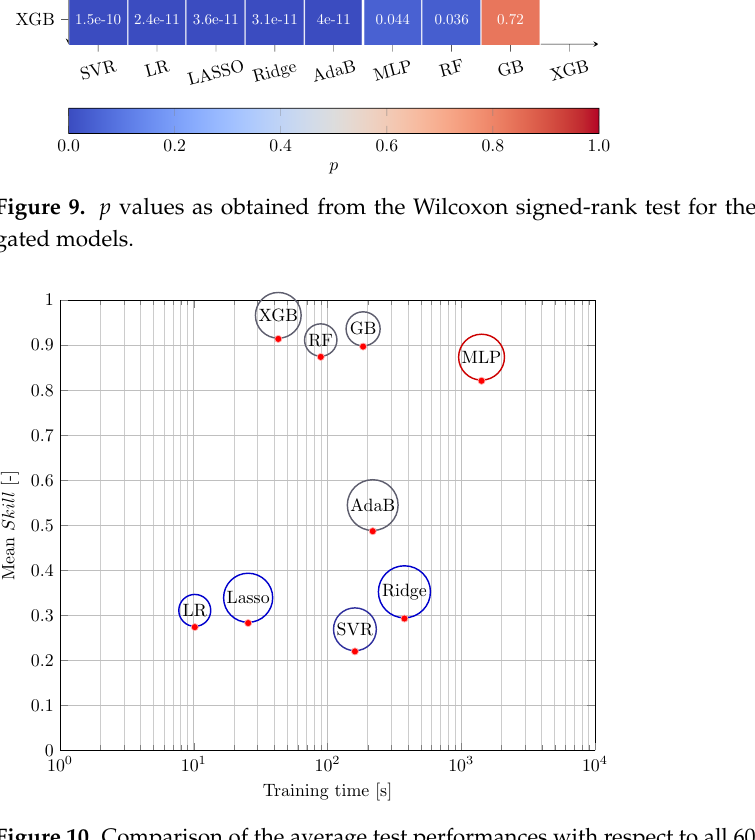
Figure 10. Comparison of the average test performances with respect to all 60 curves of the different models in relation to their required training time. The color represents the defined model categories. See text for